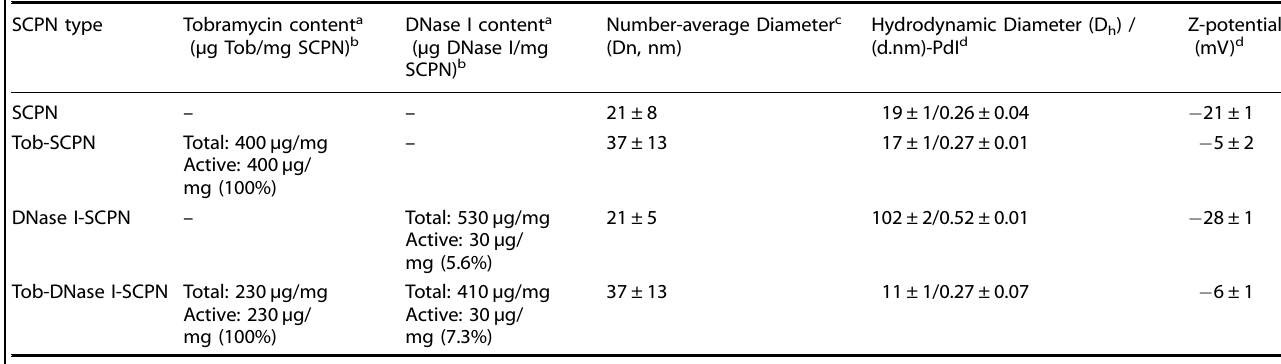
Table 1. Compositions of the different formulations (SCPN: nude nanoparticles; Tob-SCPN: nanoparticles with 40 wt% tobramycin; DNase I-SCPN: SCPN formulated with DNase I; Tob-DNase I-SCPN: SCPN that contain 23 wt% tobramycin and DNase I). SCPN